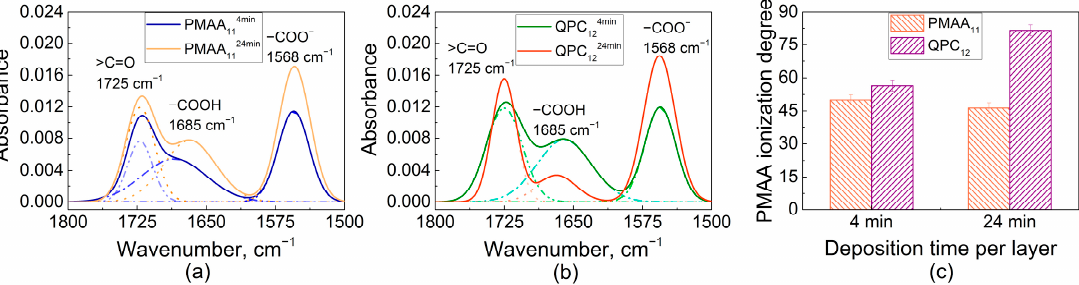
Figure 3. Fourier-transform infrared spectroscopy (FTIR) spectra of dry PMAA 114min and PMAA 1124min ( a ); FTIR spectra of dry QPC 124min and QPC 1224min ( b ); calculated values of PMAA ionization degree within QPC 124min , QPC 1224min , PMAA 114min and PMAA 1124min films ( c ).